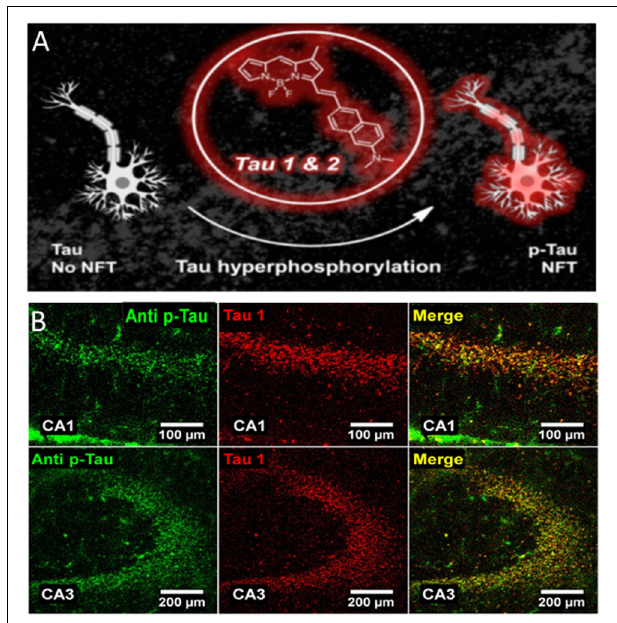
FIGURE 2 | 4,4-difluoro-4-bora3a,4a-diaza-s-indacene (BODIPY)-based probe binds to neurofibrillary tangles in a mouse model of AD. (A) Near-infrared probes (NIR) Tau 1&2 bind to NFT structures. (B) Immunostaining showing the colocalization between pTau (green signal) and Tau1 (red signal) in the CA1 (upper panels) and CA3 (lower panels) hippocampal region of a mouse treated with okadaic acid. Colocalization of the two signals is shown. Adapted with permission from Verwilst et al. (2017). Copyright 2017 American Chemical Society.